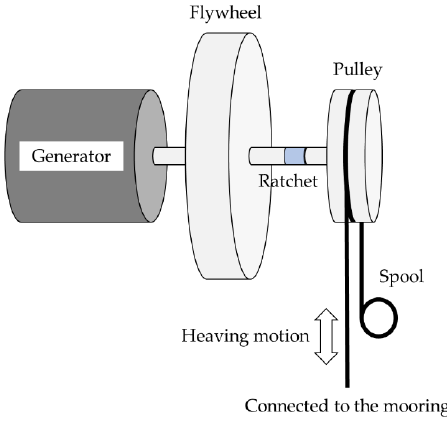
Figure 4. A typical flywheel energy storage device and a power take off (PTO) located in the Mechanical Room 1 of Figure 2a.